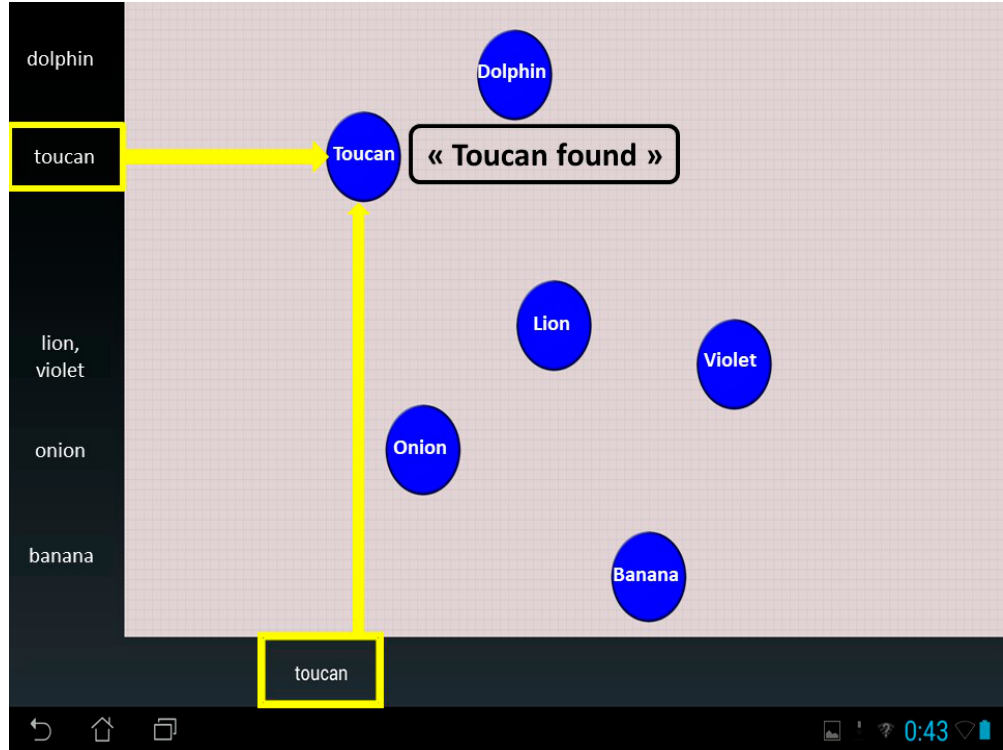
Figure 4. Schematic description of Edge Projection technique.